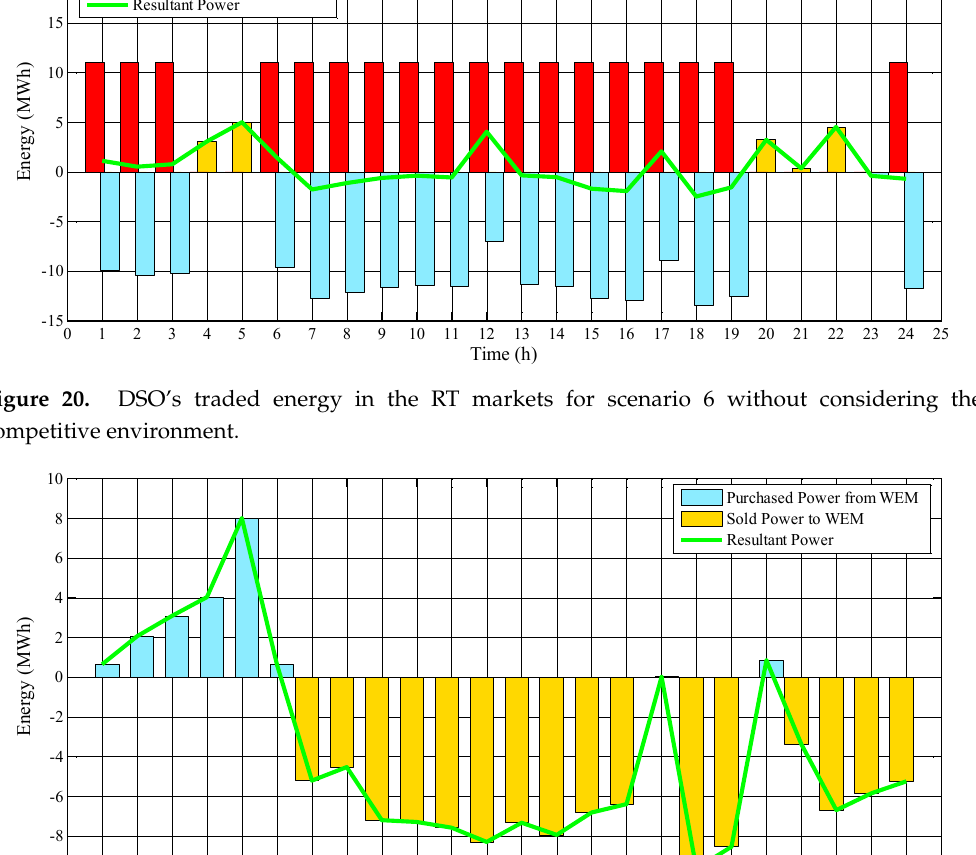
Figure 21. AG’s traded energy in the RT markets for scenario 6 without considering the competitive environment.